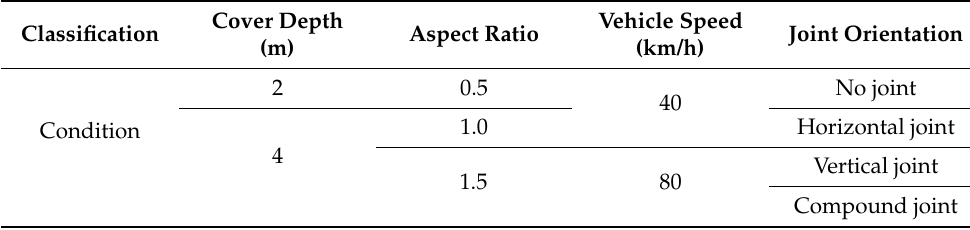
Table 1. Influence factors and levels.